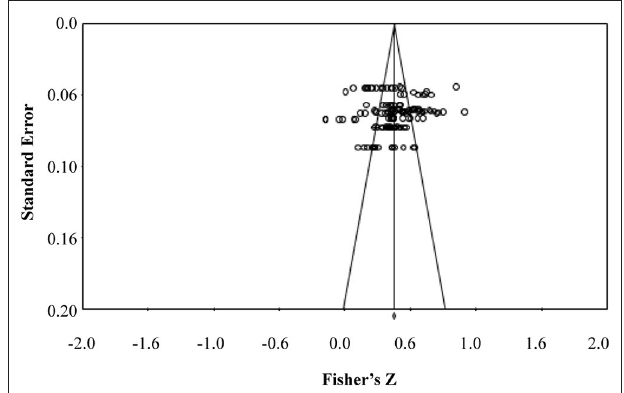
FIGURE 2 | Funnel plot of standard error by Fisher’s Z